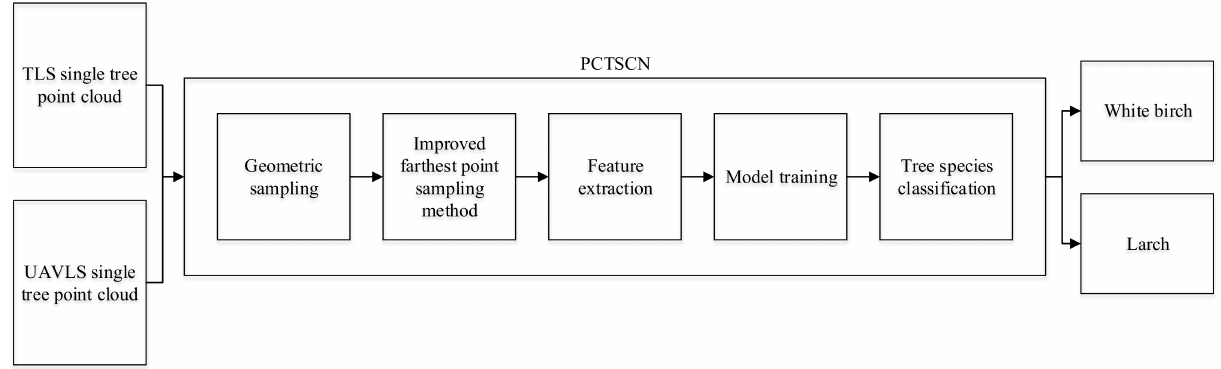
Figure 7. Point Cloud Tree Species Classification Network (PCTSCN) tree species classification